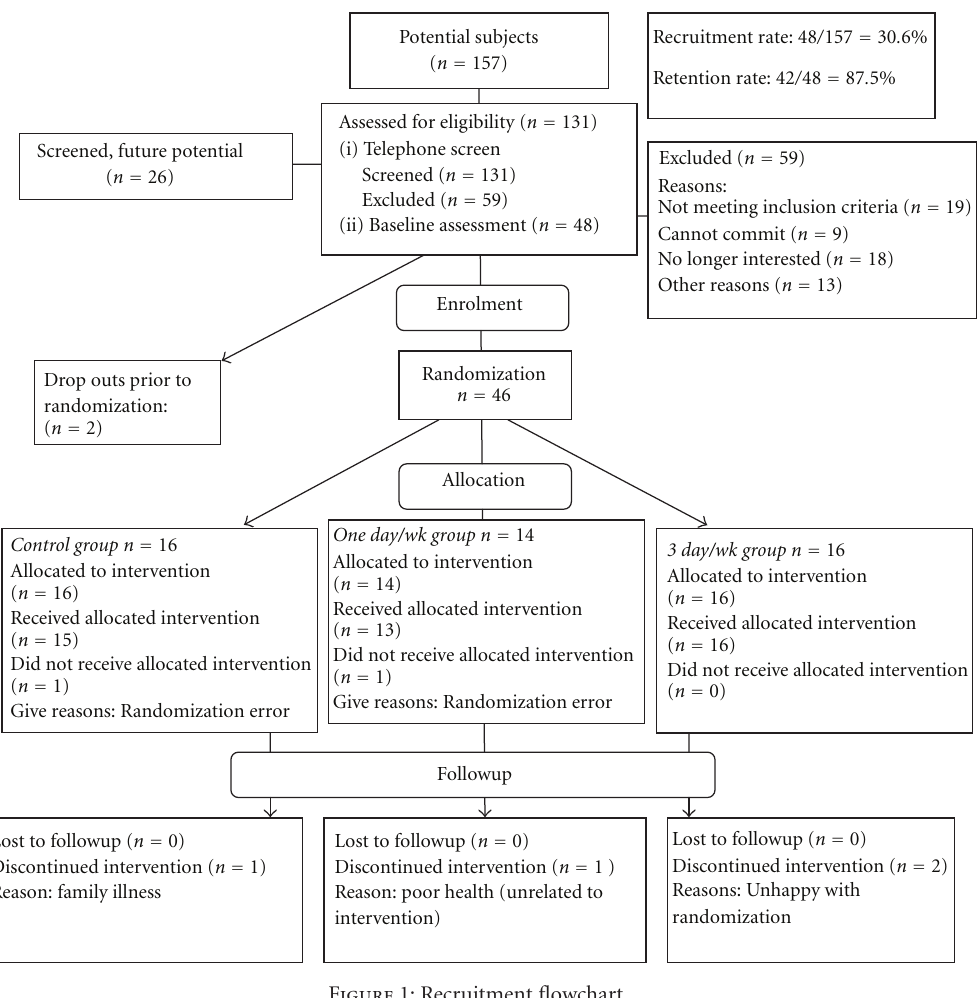
Figure 1: Recruitment